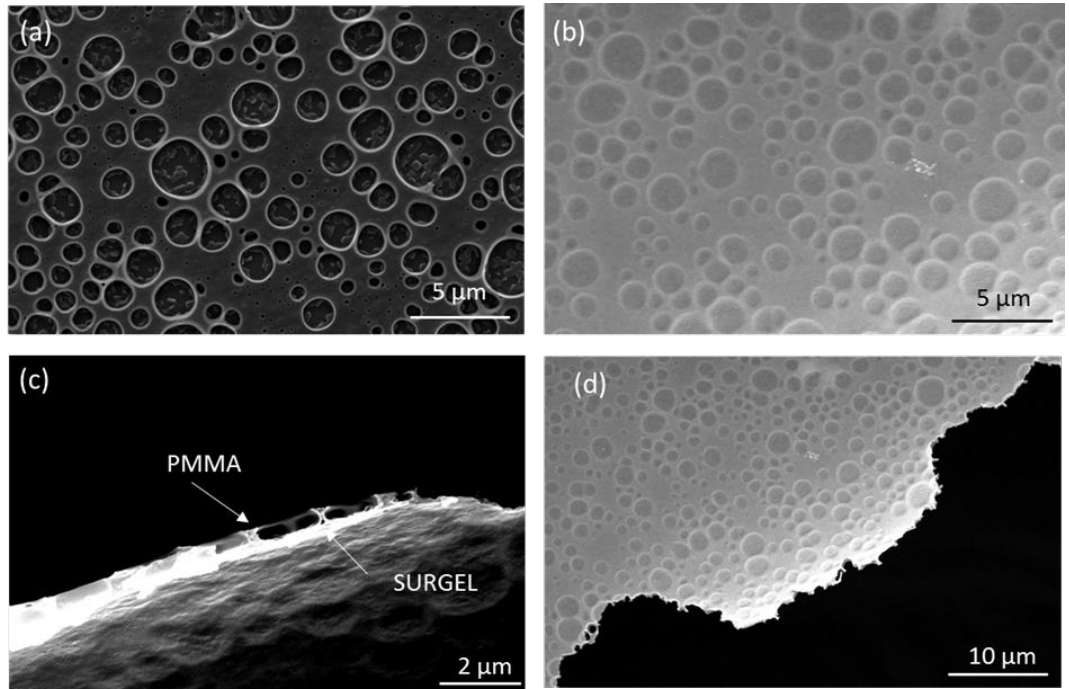
Figure 2. Scanning electron microscopy (SEM) images of SURGEL membranes supported by a por-PMMA layer: ( a ) Top view, ( b ) bottom view, ( c ) cross section at an edge region, and ( d ) bottom view at an edge region.